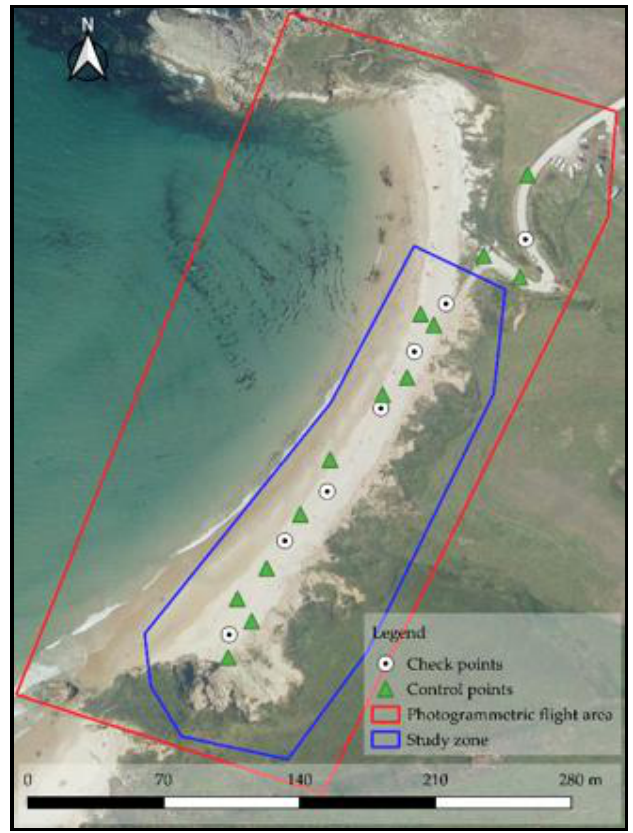
Figure 3. Distribution of the control points for the unmanned aerial vehicle (UAV).